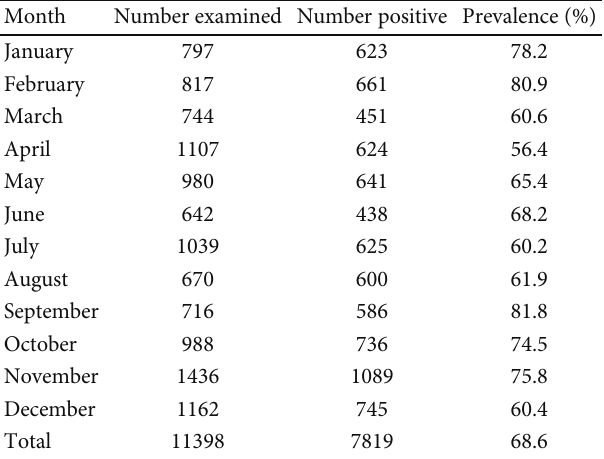
Table 2: Prevalence of malaria infection in Akure North Local Government Area of Ondo State, Nigeria.